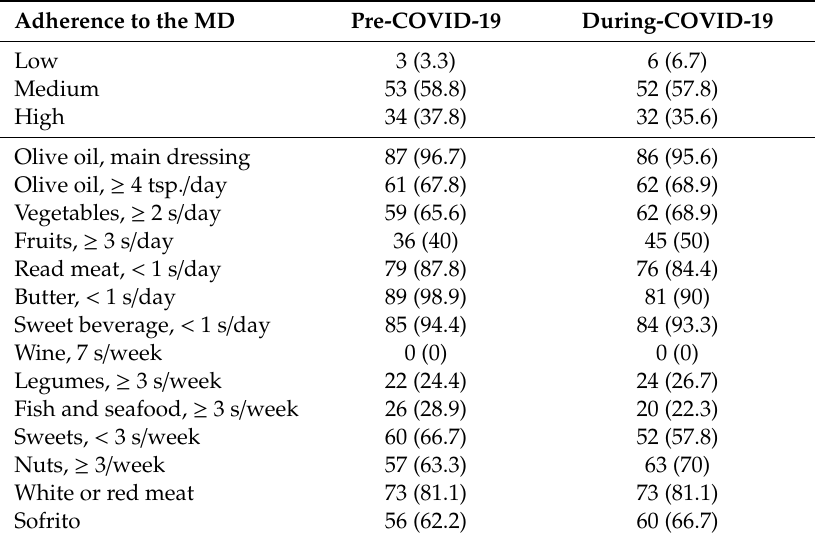
Table 5. Adherence to the MD and positive answers to the MEDAS